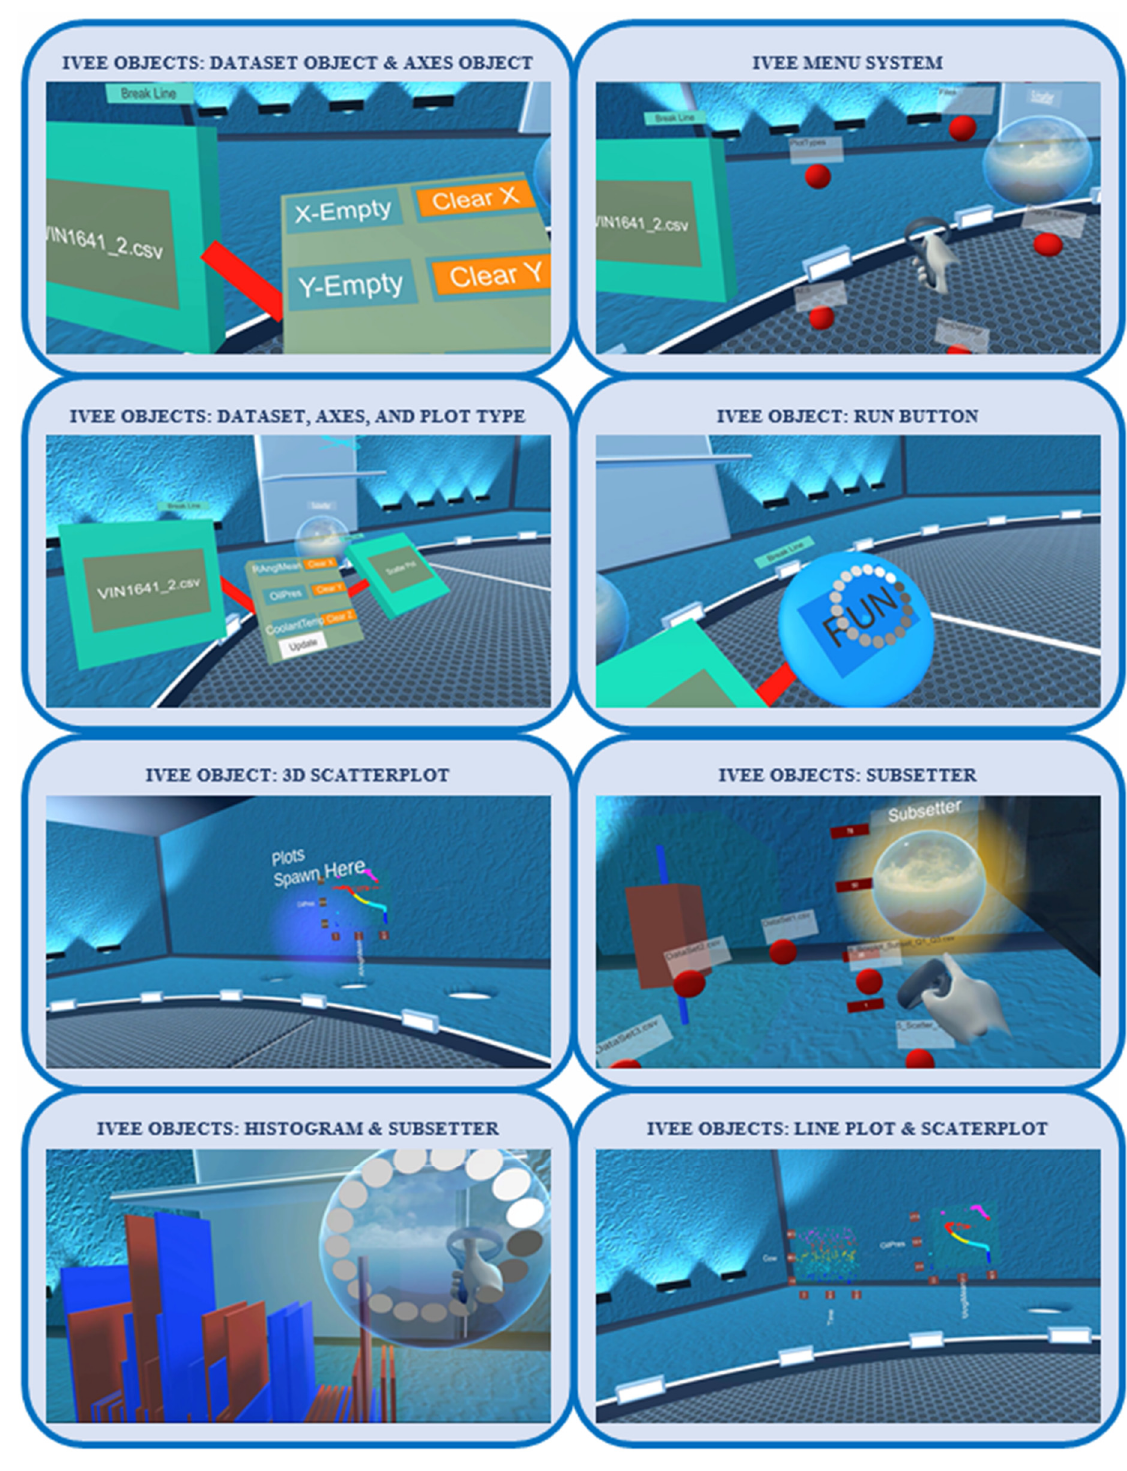
Figure 1. Latest version of IVEE prototype.